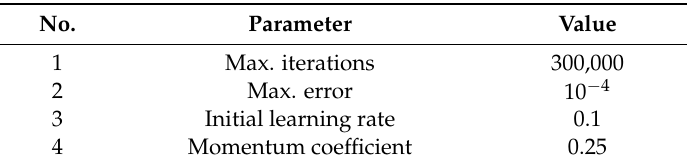
Table 8. Initial training